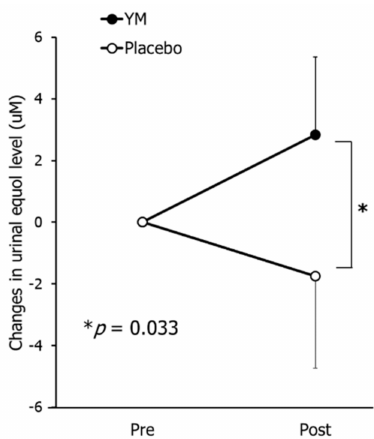
Figure 4. E ff ects of YM intake on urinal equol level. Black circles represent the YM group and the white circles represent the placebo group. Data represent the means ± SE. Data were analyzed by the Mann–Whitney U test. Asterisk indicates significant di ff erences between groups (* p <